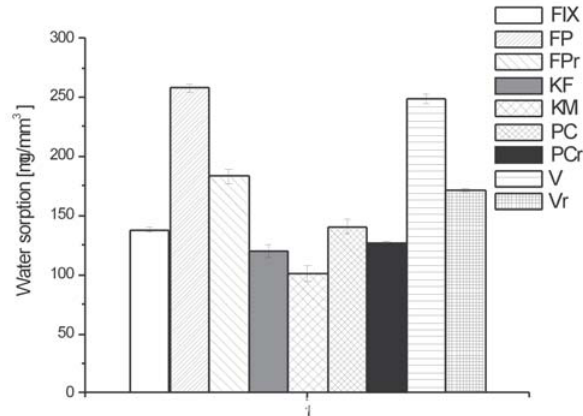
FIGURE 2 - Water sorption of the studied glass-ionomer cements